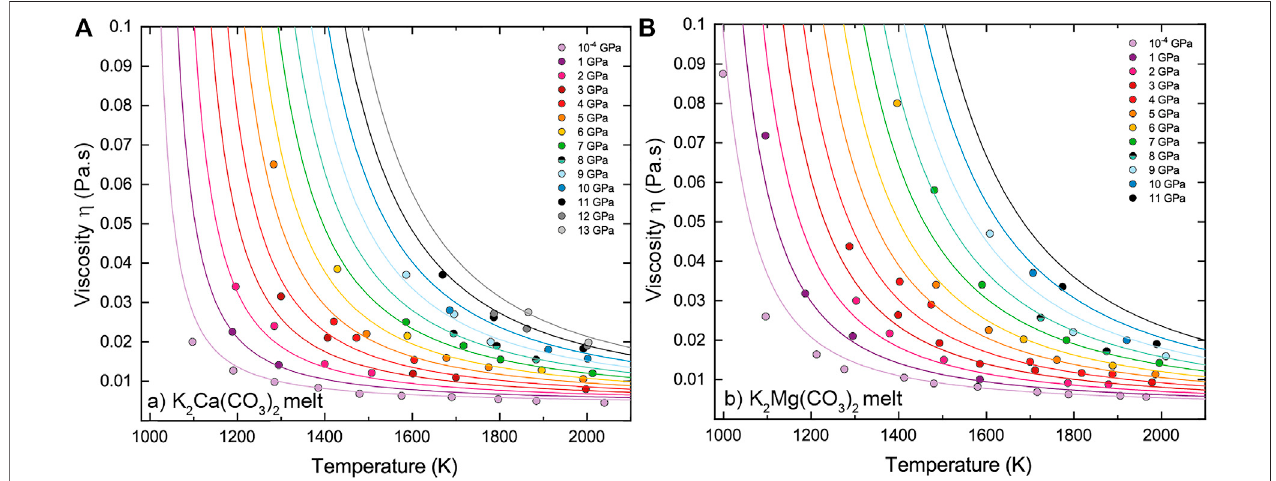
FIGURE2| Effectoftemperatureontheviscosityof (A) K 2 Ca(CO 3 ) 2 (KC)and (B) K 2 Mg(CO 3 ) 2 (KM)meltsalongisobarsfromambientpressureto13 GPa.Symbols are MD calculated viscosities and lines represent fi ts to the data by the Vogel-Fulcher-Tammann (VFT [ Eq. 6 ]) model. Colors have the same meaning in both fi gures.